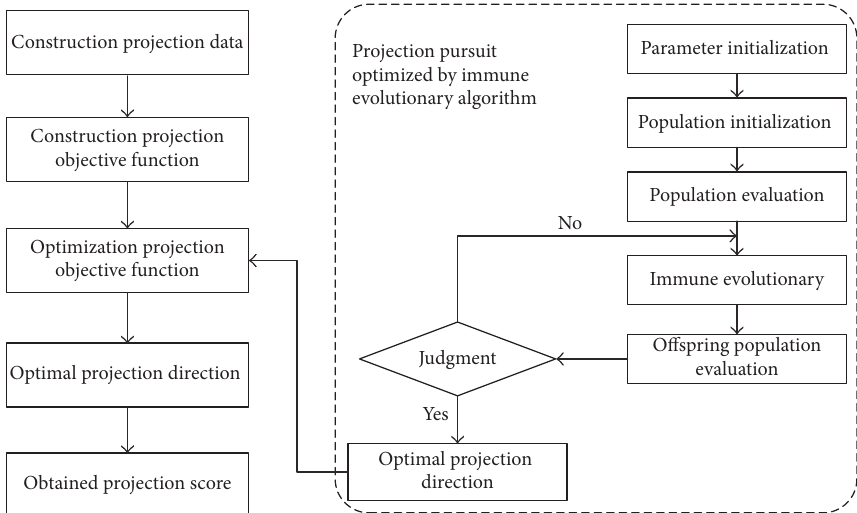
Figure 2: Flow diagram of